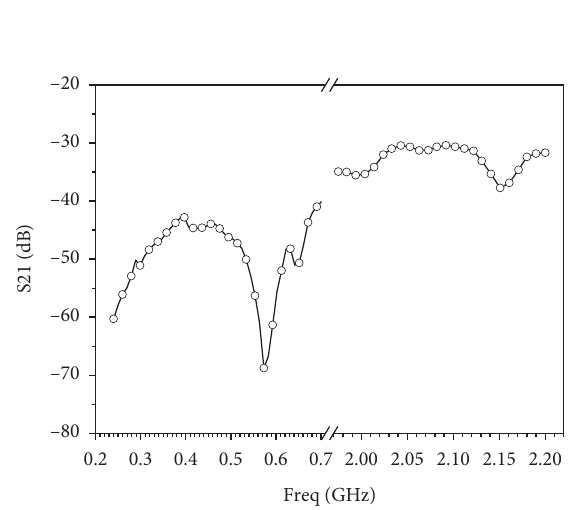
Figure 10: Port isolation of the proposed